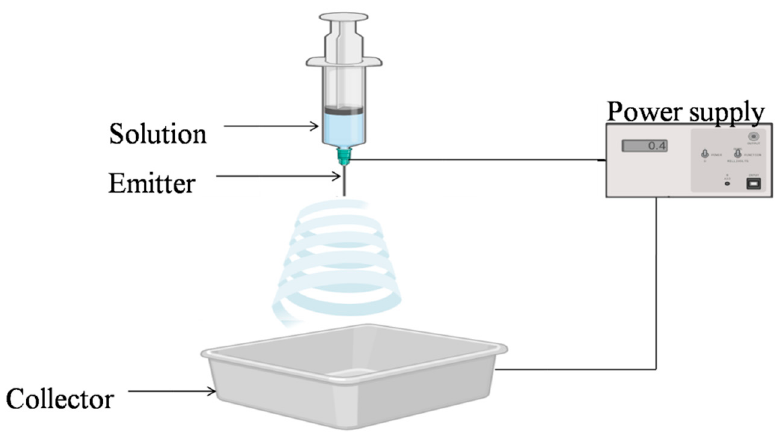
Figure 3. Electrospinning method.